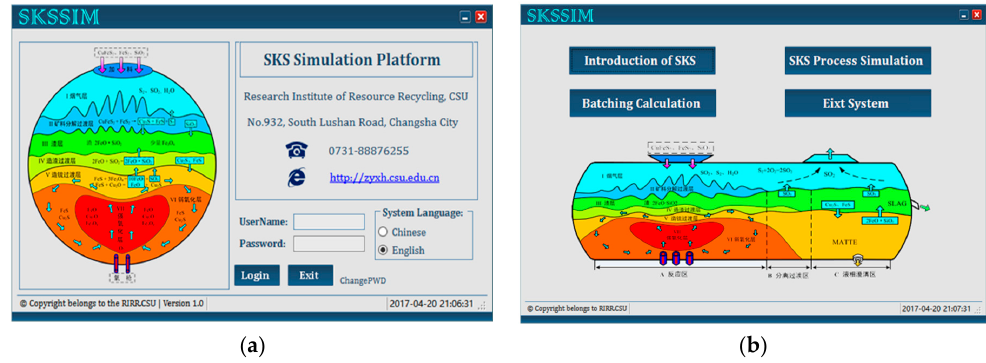
Figure 4. Login screen and navigation interface of SKSSIM: ( a ) login screen; ( b ) navigation interface.